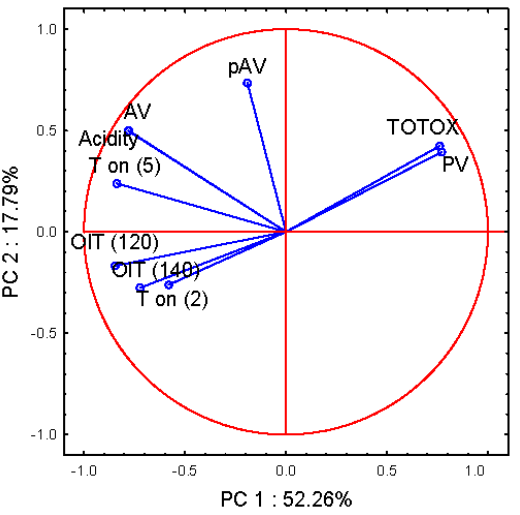
Figure 10. Oxidative stability parameters of five cold ‐ pressed flaxseed oils.